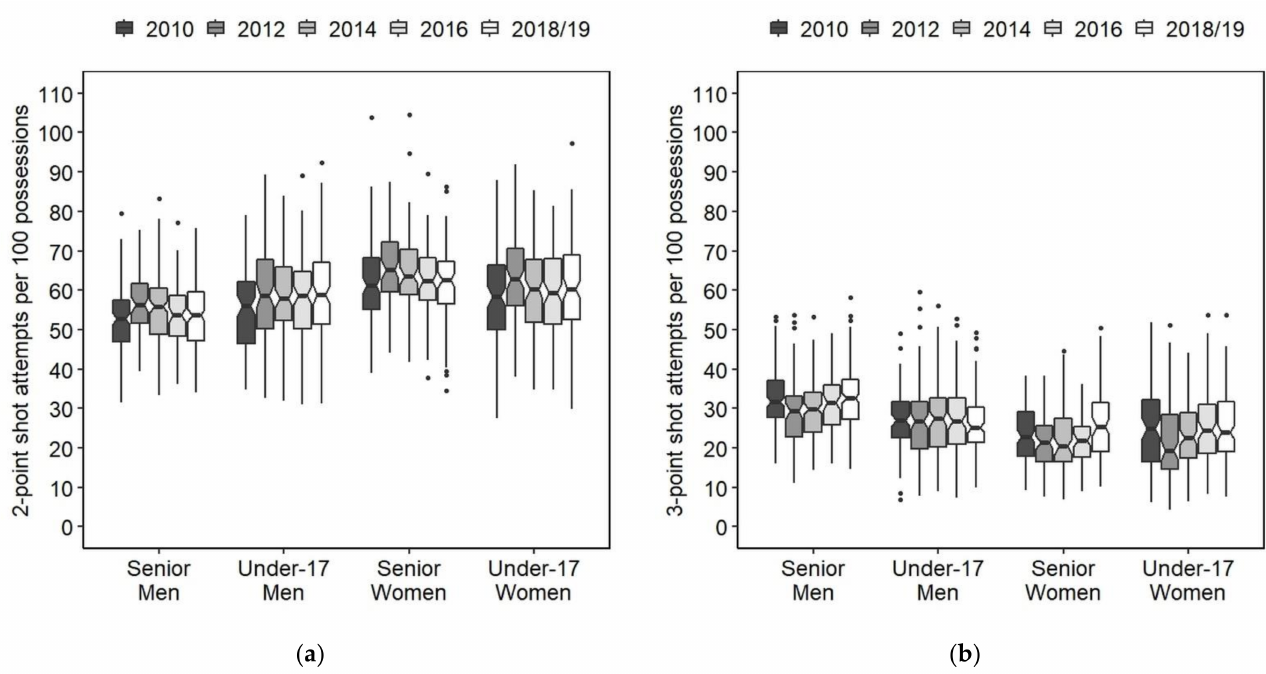
Figure 1. Boxplots of ( a ) two-point and ( b ) three-point shot attempts per 100 possessions for each category and year. The dots beyond the whiskers show outliers outside the 1.5 interquartile range.